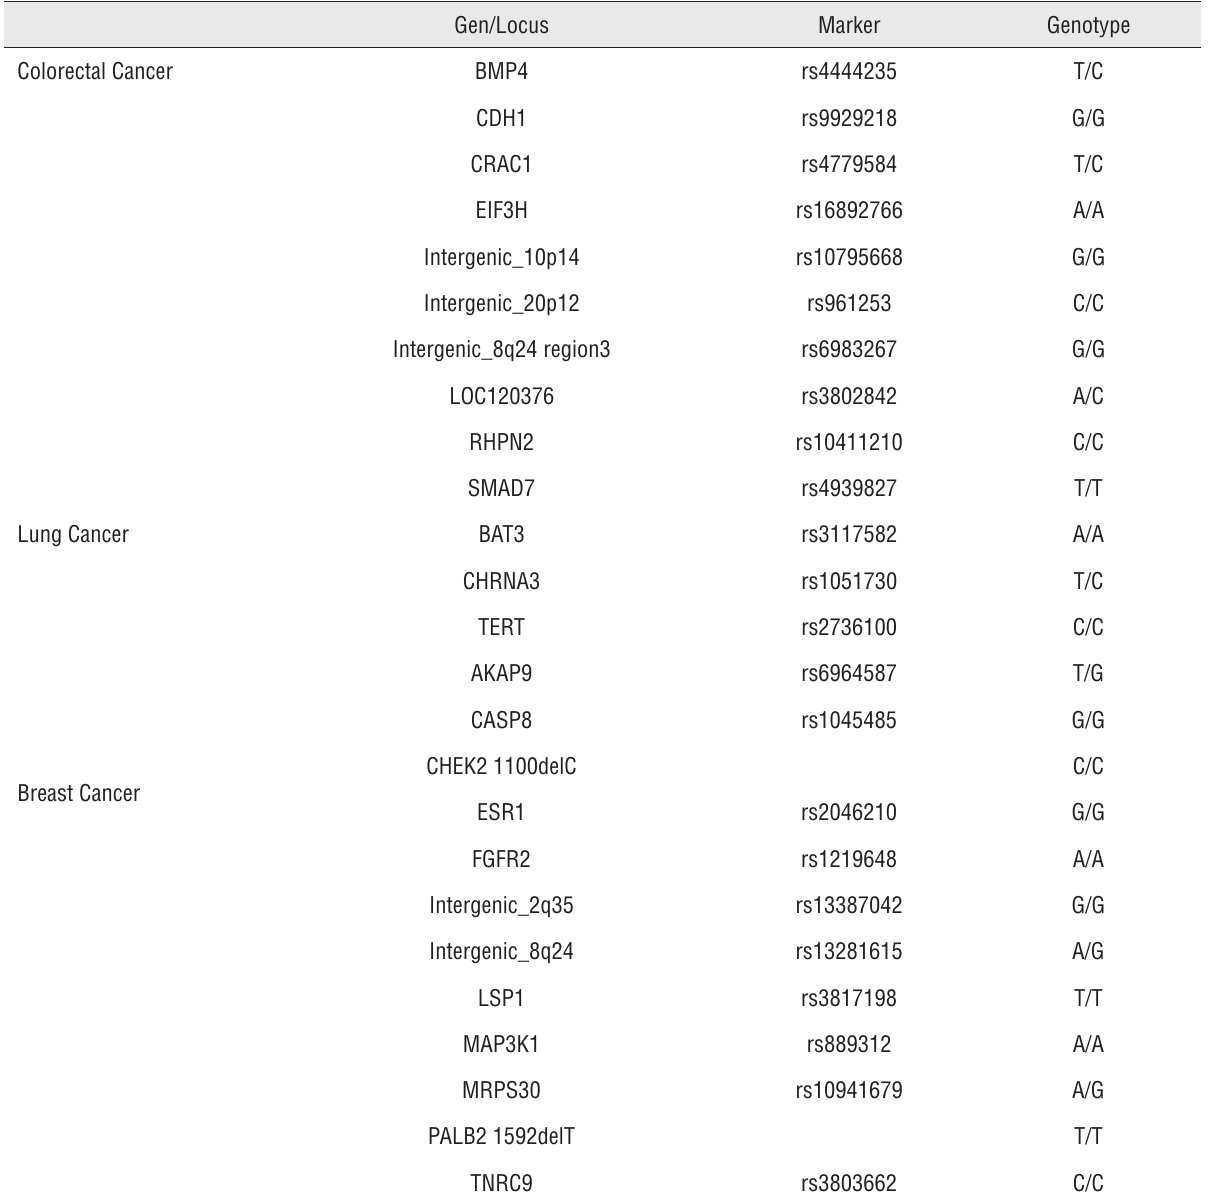
Table 1 - SNP genotyping results associated with some cancer